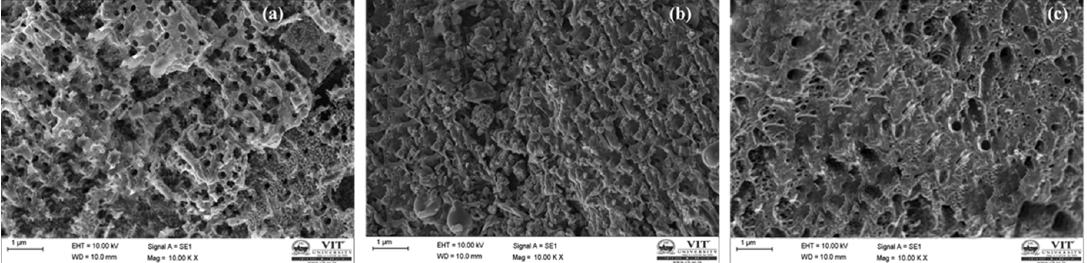
Figure 7. SEM micrographs of the activated-carbon-coated glass beads: ( a ) before adsorption; ( b ) after adsorption; and ( c ) after desorption.